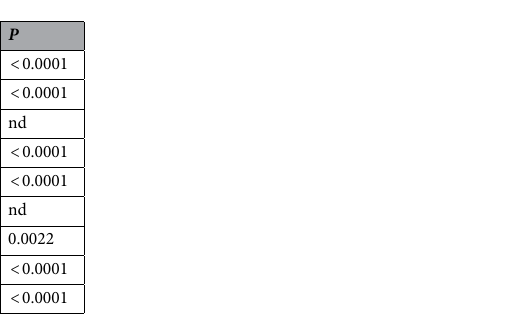
Table 4. Combined AUC ROC curve data. LAF, combined LDH-ACE-fibrinogen; LAF-SIRI, LAF plus SIRI index; LAF-SIRI-FRT, LAF-SIRI plus FVC and DLCO; AUC, area under the ROC curve; 95% CI, 95% confidence interval; P , p